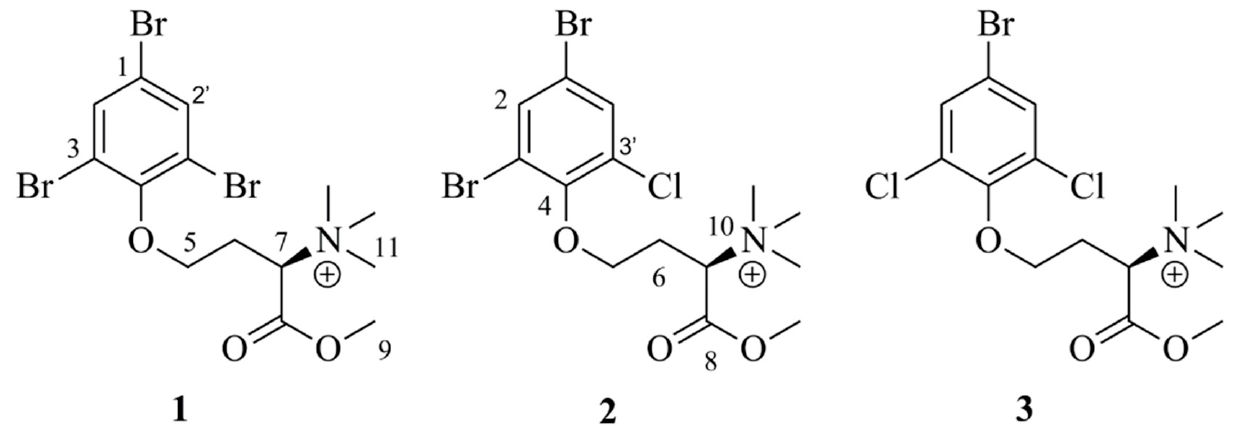
Figure 1. Structures of purpuroine K–M (compound 1 – 3 ) isolated as part of this work.